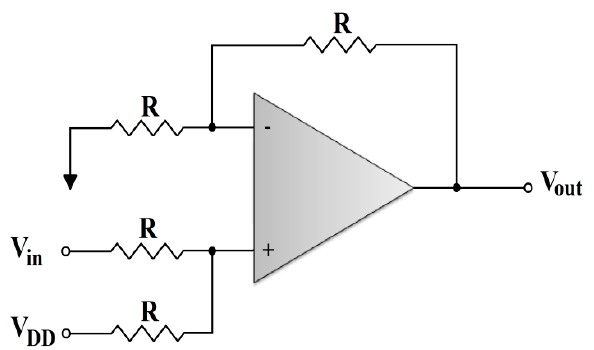
Figure 8. Non-inverting summing amplifier circuit.